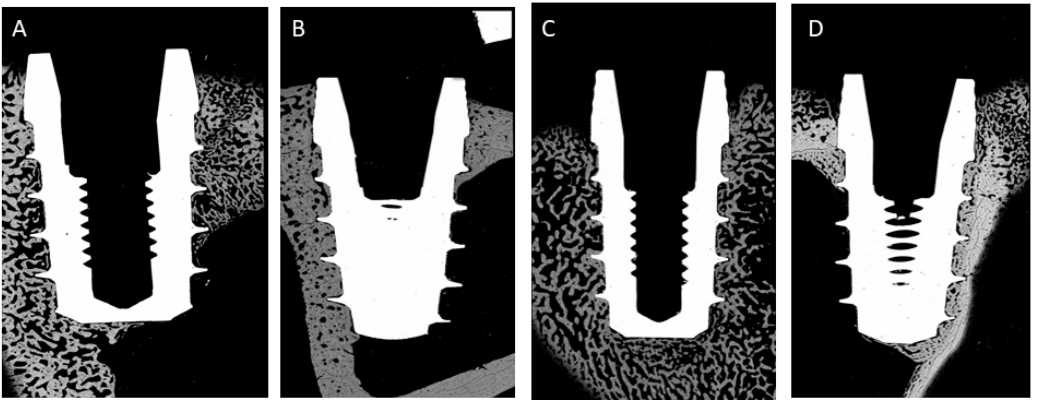
Figure 7. Histologies of the different bone-level dental implants inserted 0.5 mm above of bone level (h = +0.5 mm). ( A ) 3 weeks implanted and bone thickness of 1.5 mm; ( B ) 6 weeks implanted and bone thickness of 1.5 mm; ( C ) 3 weeks implanted and bone thickness of 2.5 mm; ( D ) 6 weeks implanted and bone thickness of 2.5 mm.